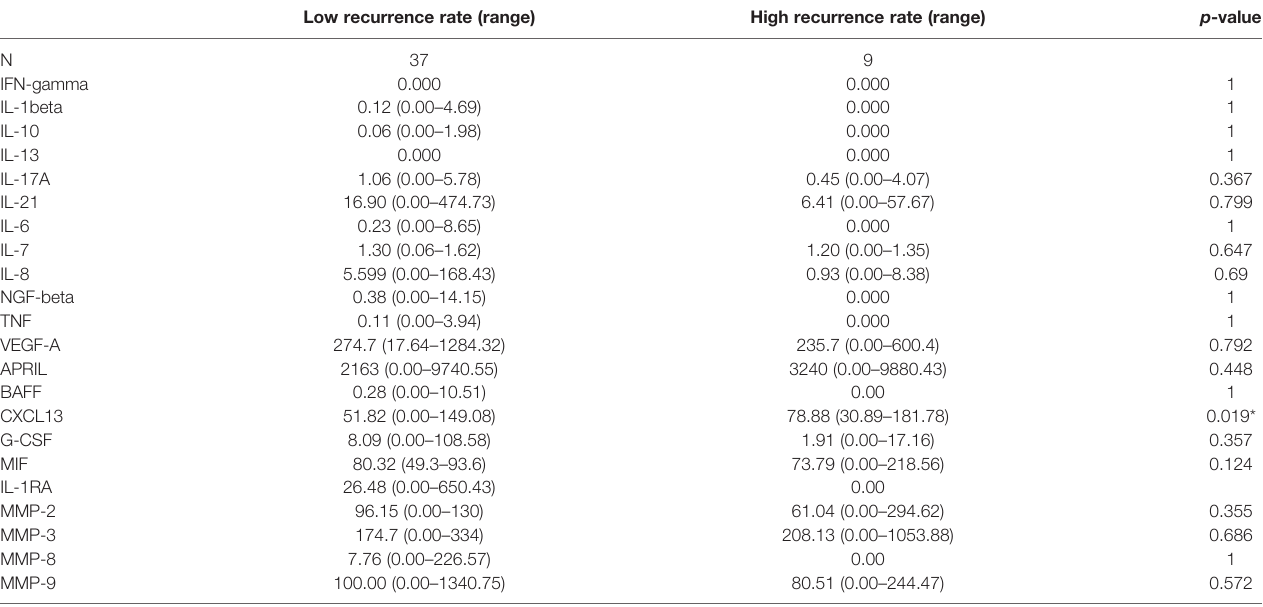
TABLE 2 | Quantitative data of in fl ammatory cytokines in NMOSD